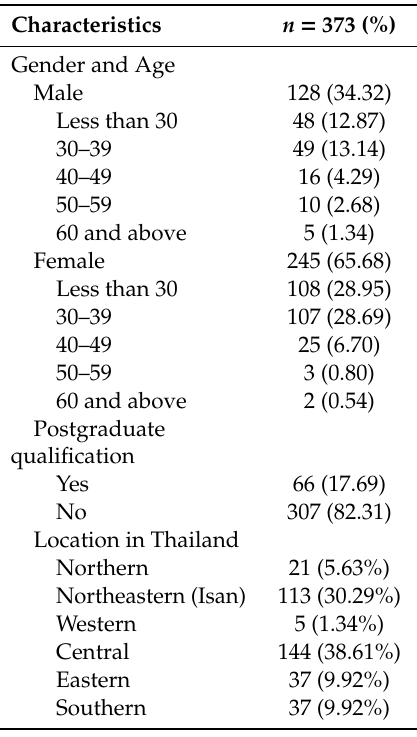
Table 3. Demographic of the